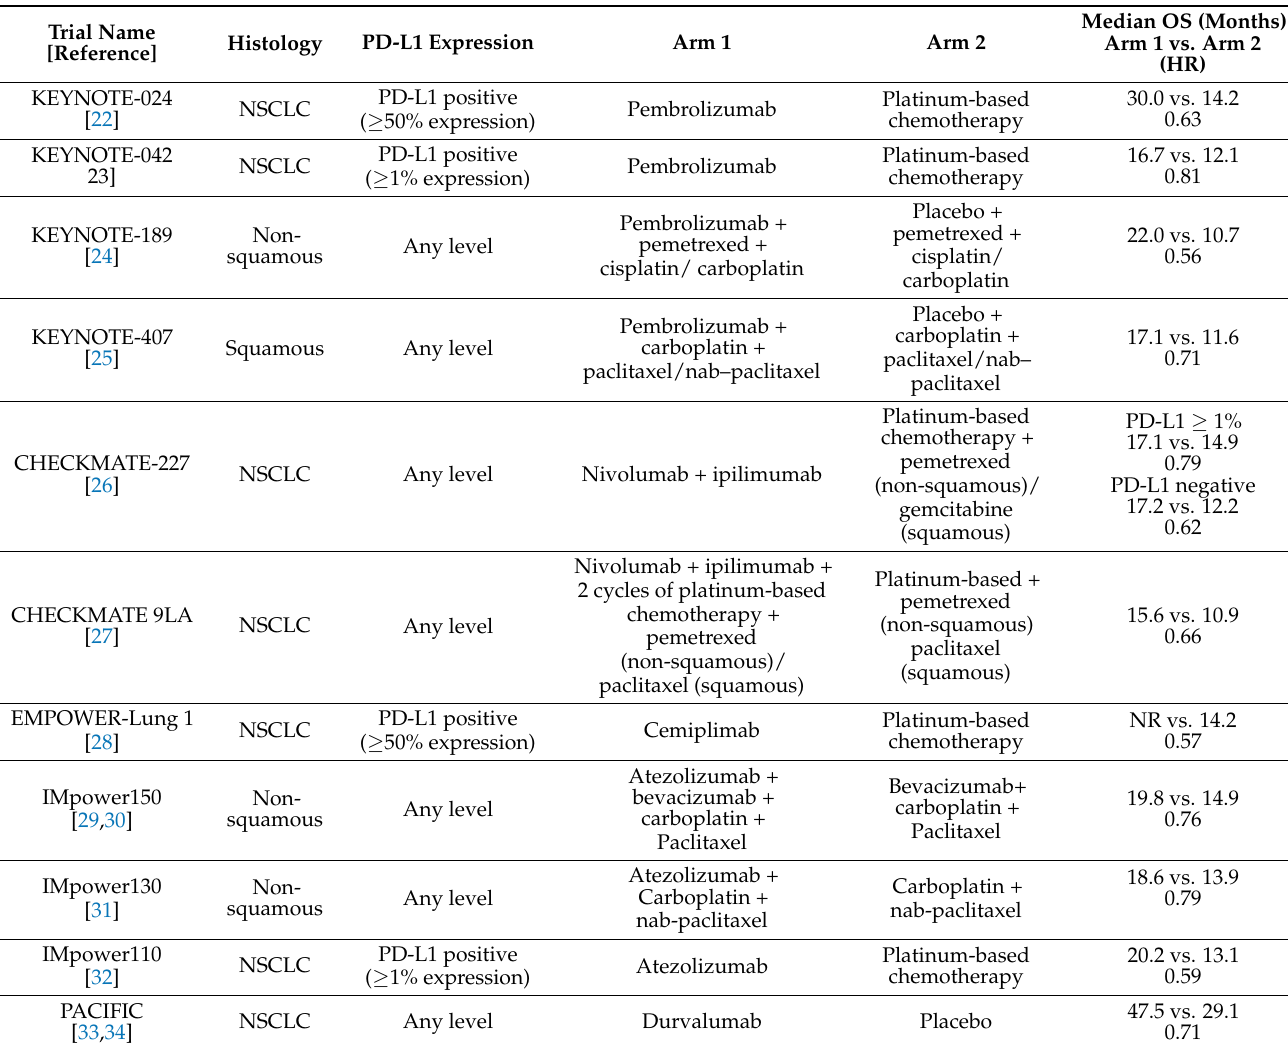
Table 1. Summary of main clinical trials approving anti-PD-1/PD-L1 and anti-CTLA-4 ICIs as front-line NSCLC